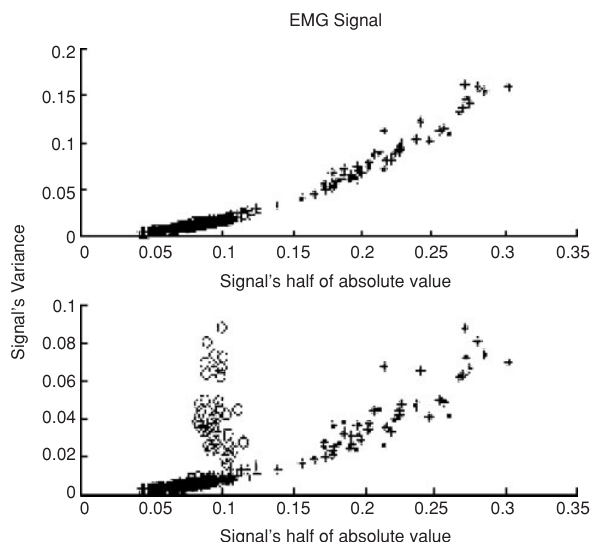
Figure 5 Electromyograph of the variance against the stocking of the absolute value of the signal. moment σ 4 , the absolute value of the fifth moment | σ 5 | , and the number of times the signal potential passes through or touches zero (i.e., ZCs). Also computed for each signal were the cross correla- ( τ ), the power spectra tions between the bicep signal R b S ( ω ), computed by fast Fourier transform, and the signal b ( v ). Density and correlation were later voltage density D b discarded because they did not apparently contribute class separation, that is, in distinguishing between motions. S ( ω ) and R ( τ ) have both 800 components, each of b b which is a measurement variable. Although the information content of an autocorrelation and a power spectrum is in a sense redundant, and although R (0) = σ 2 , all of these are computed to simplify the process of feature selection. The measurement space, therefore, has 2058 components.